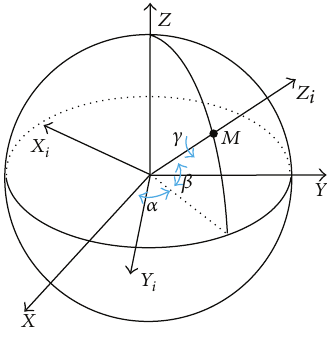
Figure 3: Attitude sphere